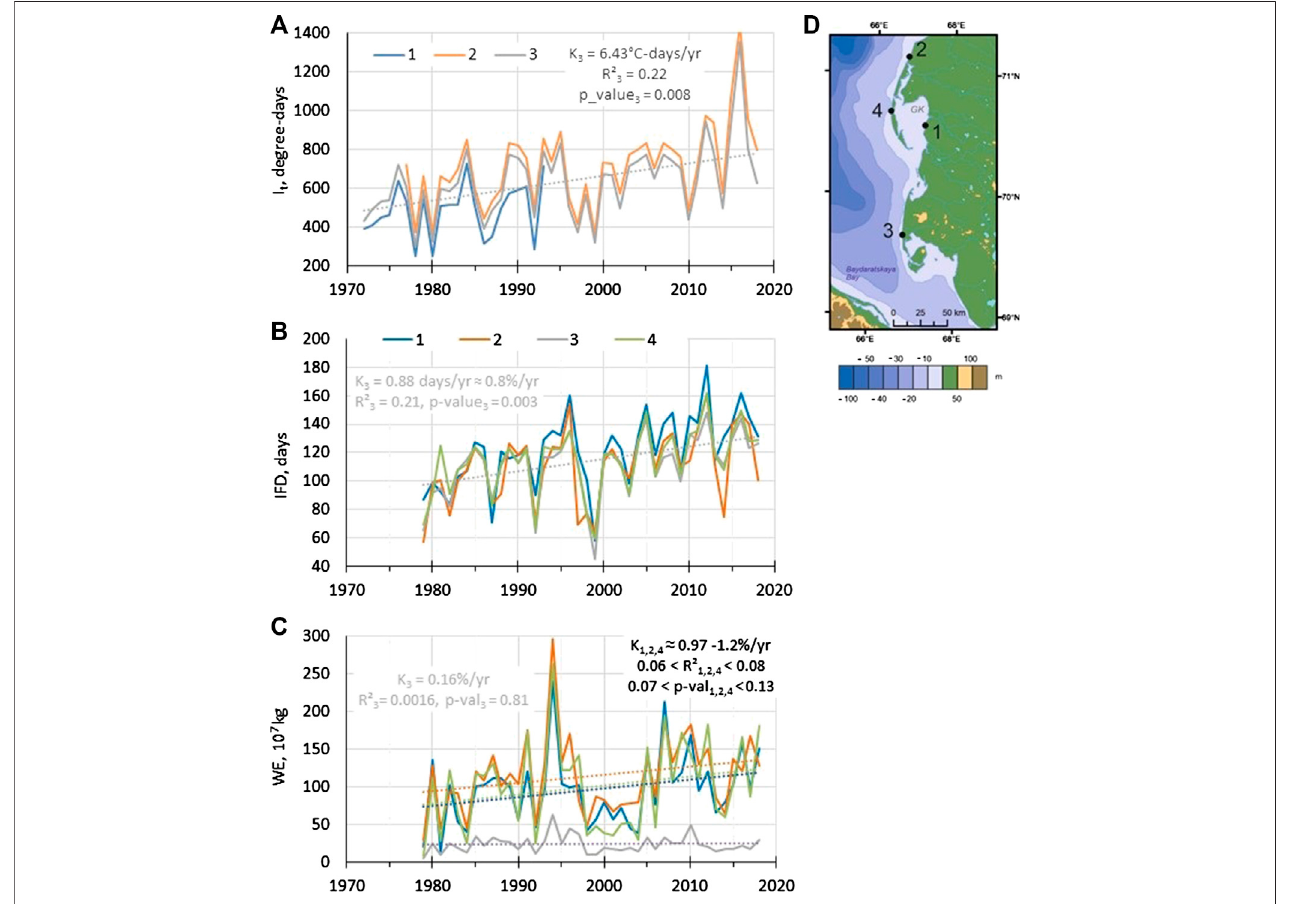
FIGURE 8 | (A) Air thawing index (I t ) according to observational data and ERA Interim reanalysis at the Gulf of Kruzenstern (1), Kharasavey (2), and Marre-Sale (3). (B) Seaice-freeperiodduration(IFD)attheGulfofKruzensterneasterncoast(1),Kharasavey(2),Marre-Sale(3)andoutersideatSharapovyKoshkiIslands(4); (C) Wind- wave energy potential (WE) evolution at the Gulf of Kruzenstern eastern coast (1), Kharasavey (2), Marre-Sale (3) and outer side at Sharapovy Koshki Islands (4). The trends for the Gulf of Kruzenstern are shown as dotted lines together with their slope (K), determination coef fi cient ( R 2 ) and p -value; (D) map showing the four sites for which the hydrometeorological parameters were